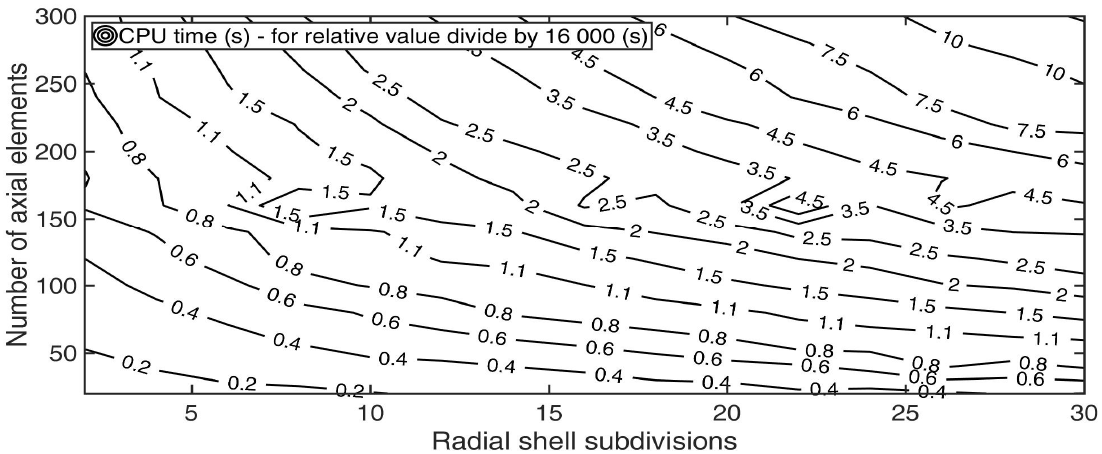
Figure 17. Estimations of maximal relative errors at the outlet of the pipe (Case 1), where the red arrow signifies the ideal direction for discretization.